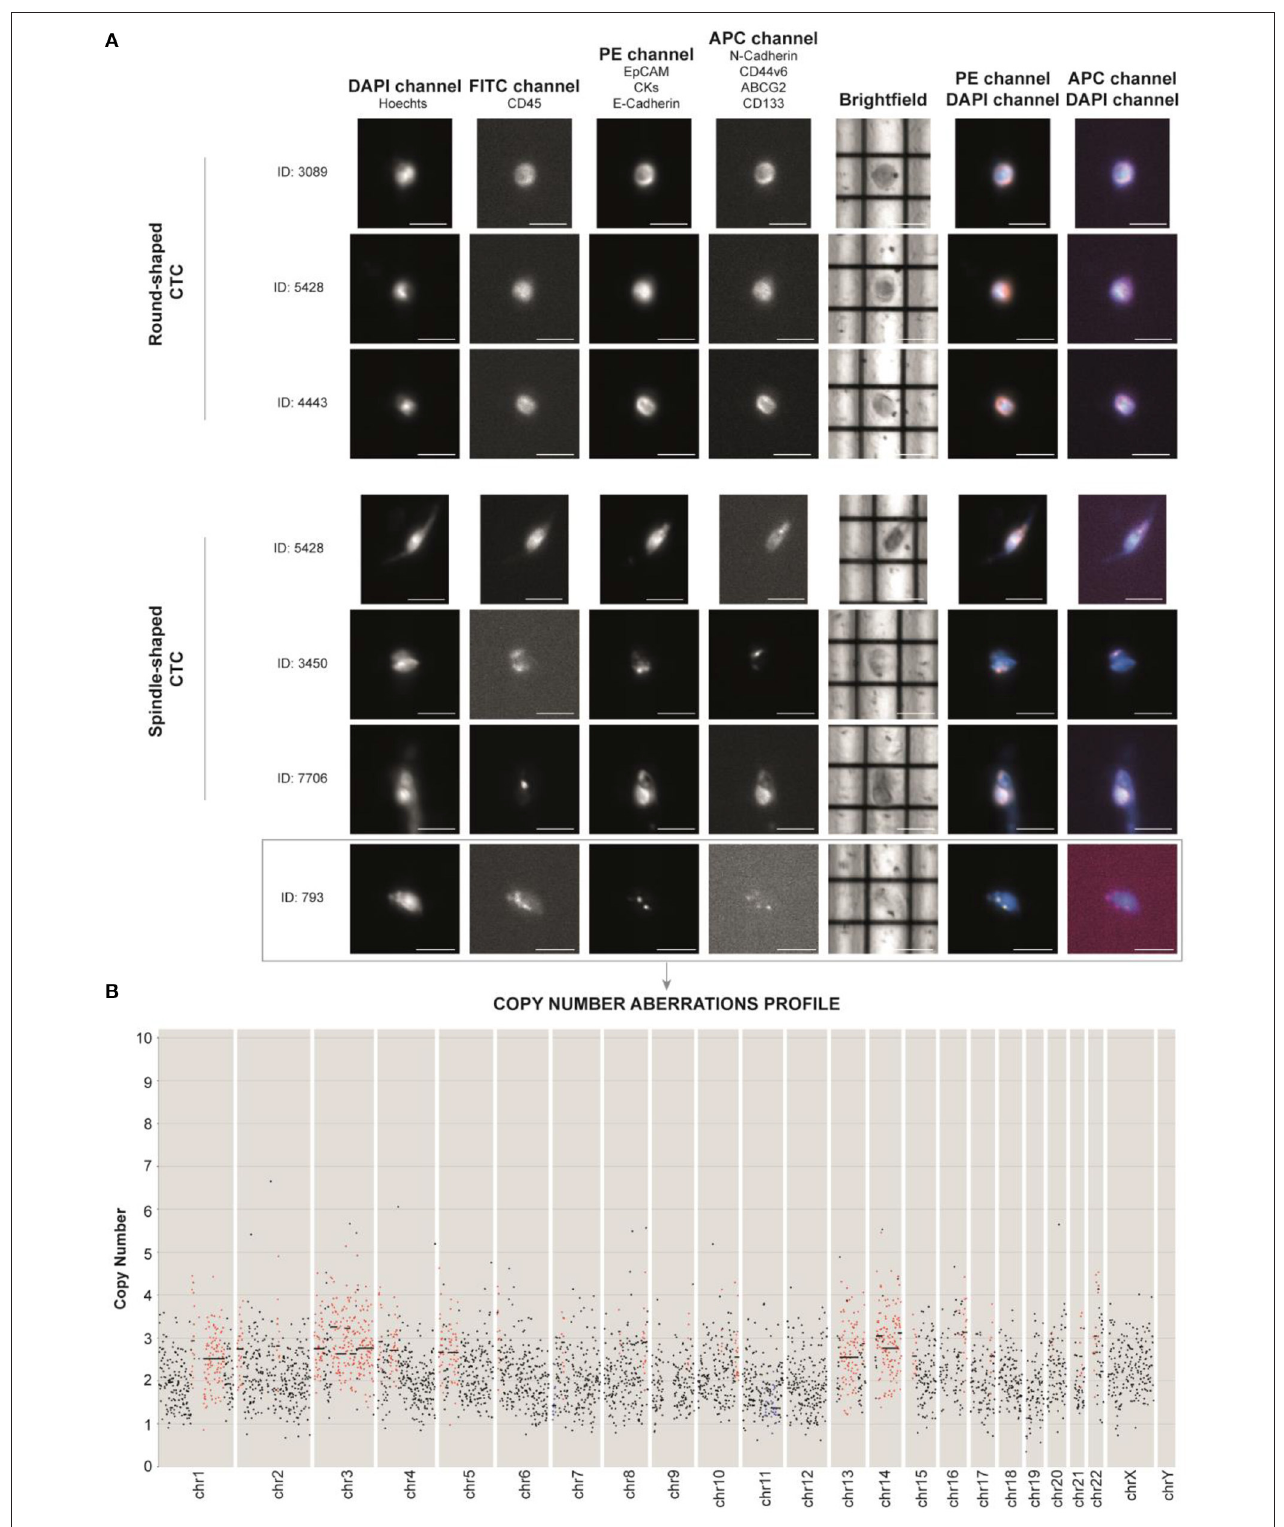
FIGURE 3 | (A) DEPArray images of the most representative single circulating tumor cells (CTCs) of the patient based on their shape (round- and spindle-shaped). The DAPI channel was used for nuclear staining using Hoechst 33342, PE channel for epithelial tag [anti-EPCAM, anti-cytokeratins (CKs) and anti-E-cadherin